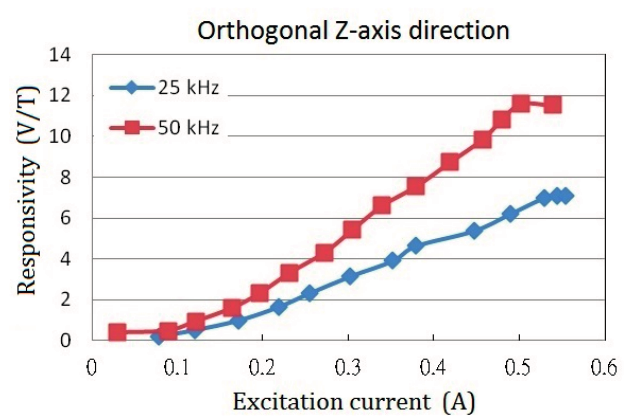
Figure 10. The orthogonal sensor responsivity ( i.e. , Z-axis) vs. the excitation current at 25 kHz and 50 kHz excitation frequencies,